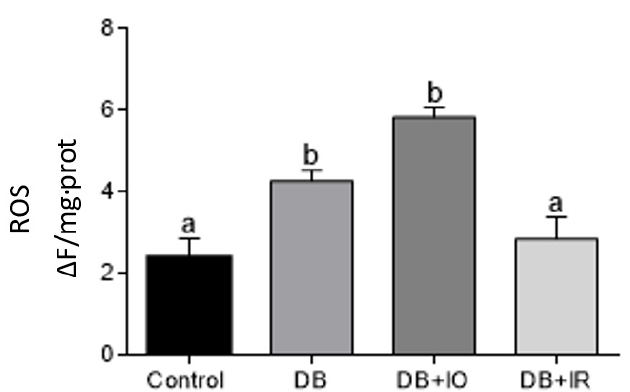
Figure 5. Effect of iron on the levels of ROS in muscle homogenates from control rats. Data are presented as group mean ± standard error. p < 0.05 ( n = 6, ANOVA plus Tukey’s post hoc test). Different letters represent statistically significant differences. DB + IO, diabetic rats with iron overload; DB + IR, diabetic rats with iron restriction diet.